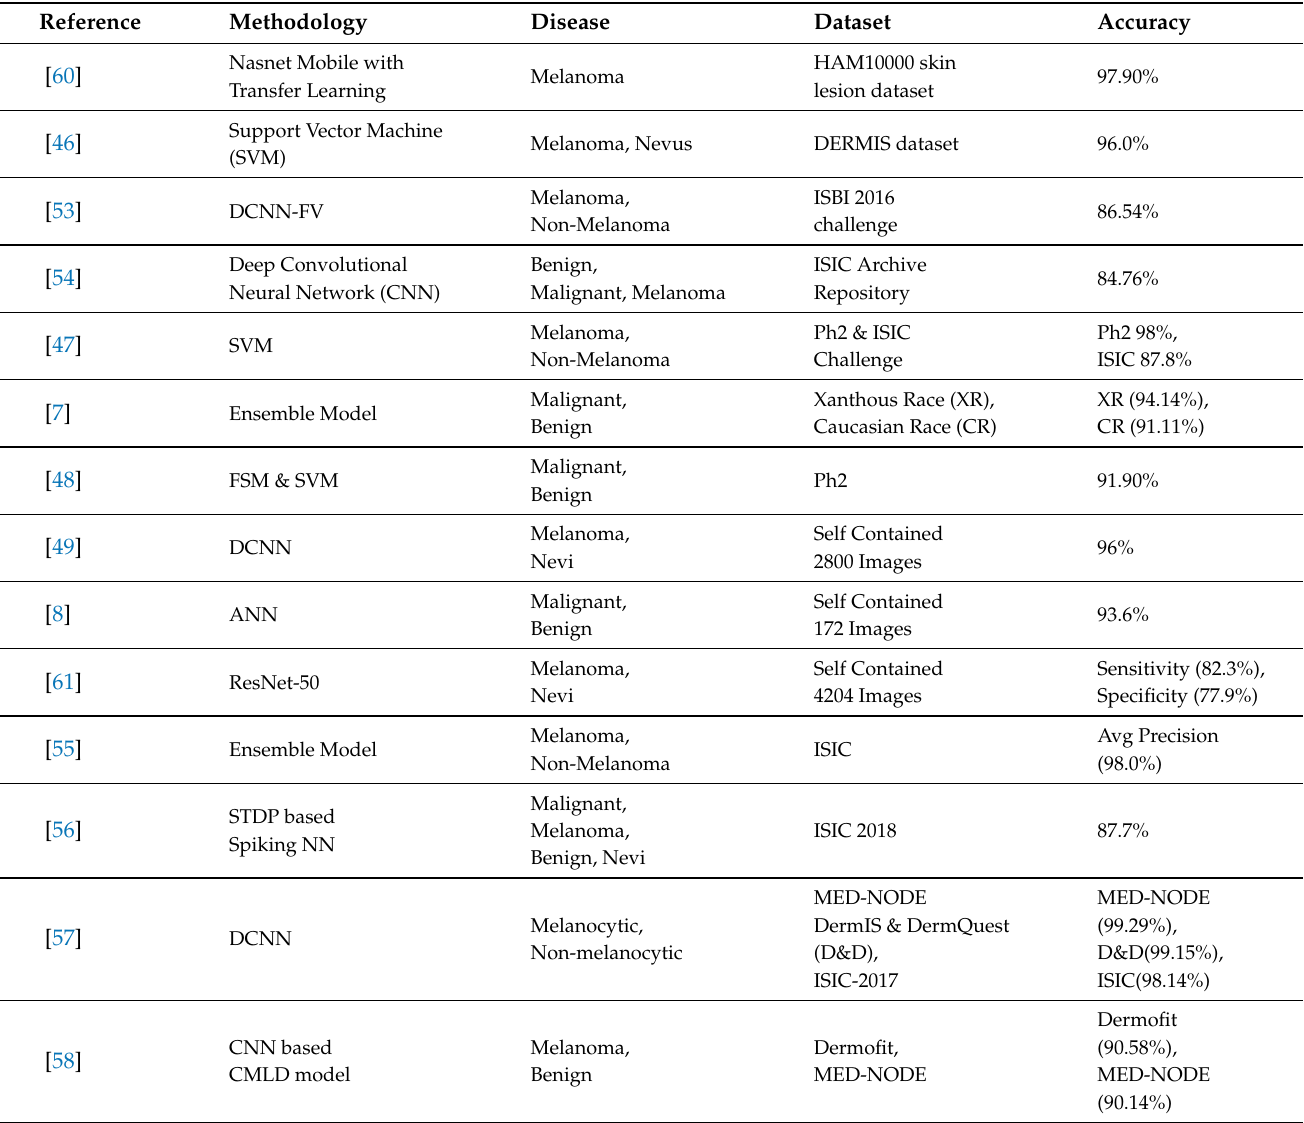
Table 1. Related work